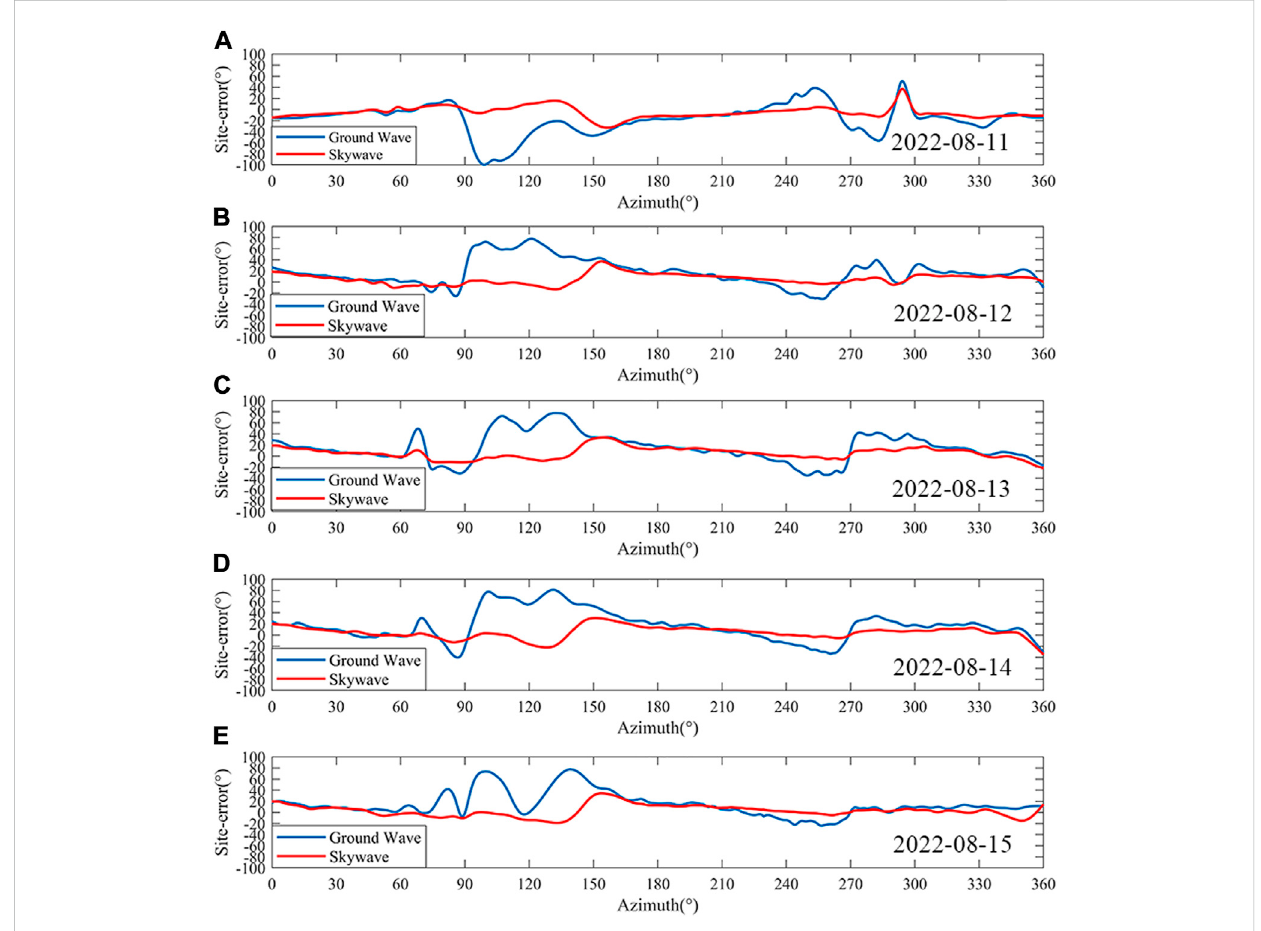
FIGURE 9 Fitting results for site error on different dates. (A) On August 11; (B) On August 12; (C) On August 13; (D) On August 14; (E) On August 15.